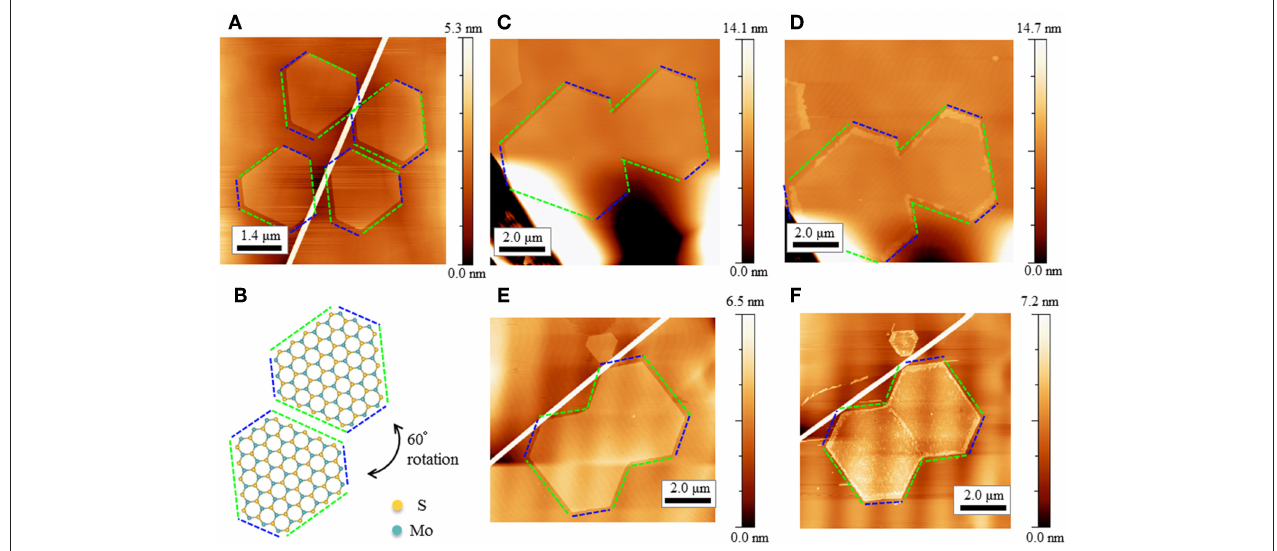
FIGURE 1 | (A) An AFM image of monolayer MoS 2 grown on h BN. Long and short edges of MoS 2 flakes are marked by green and blue dotted line, respectively. (B) Structural model of the grown MoS 2 with relative angle of 60 ◦ . (C,D) An AFM image of MoS 2 before and after the oxidation. The relative angle between the two grains in this case is 0 ◦ . (E,F) An AFM image of MoS 2 before and after the oxidation. The relative angle between the two grains in this case is 60 ◦ . White linear contrasts in Figures 1A,C,F are wrinkles in hBN